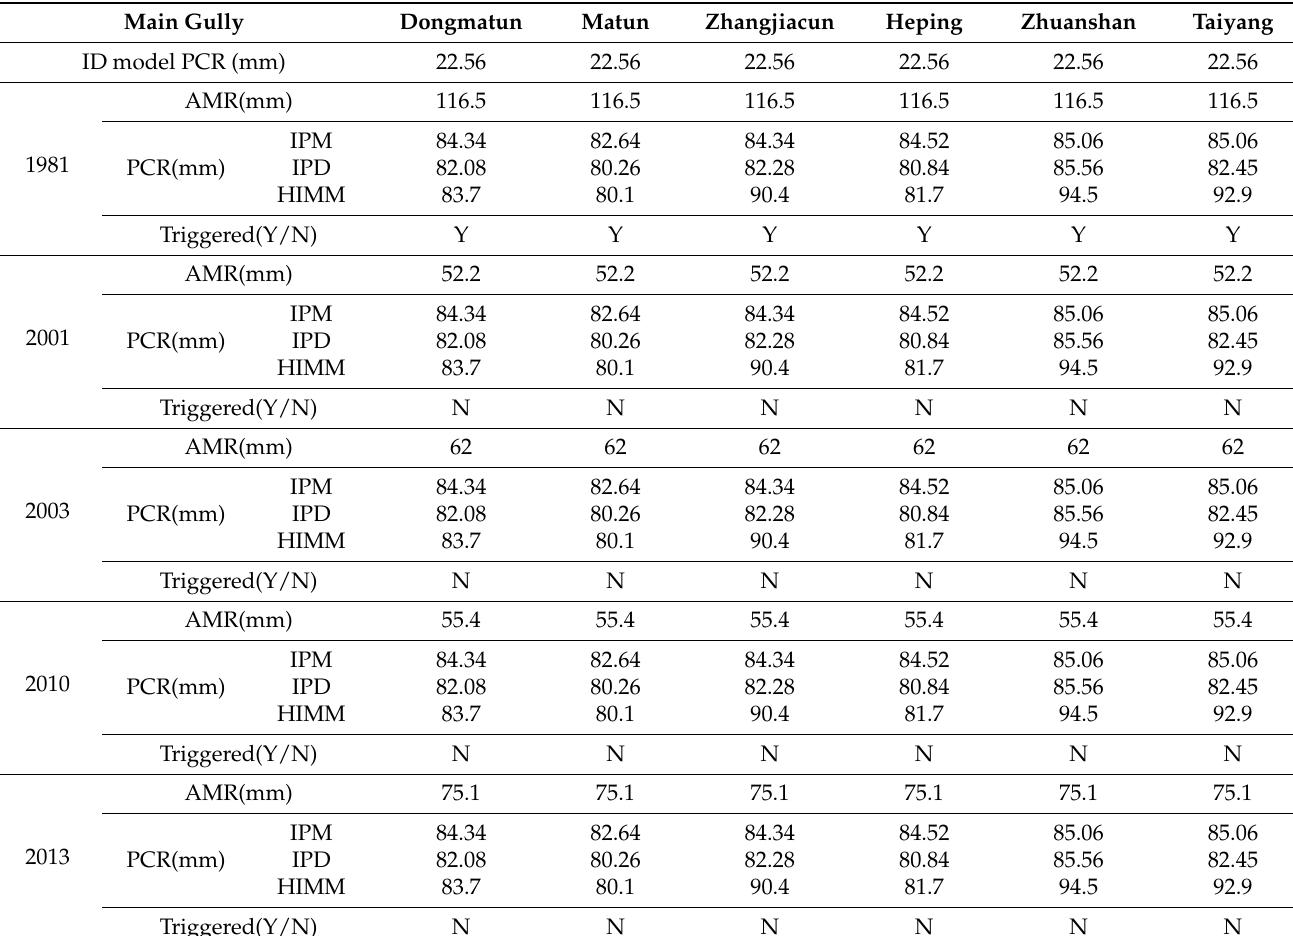
Table 9. Validation of critical rainfall prediction